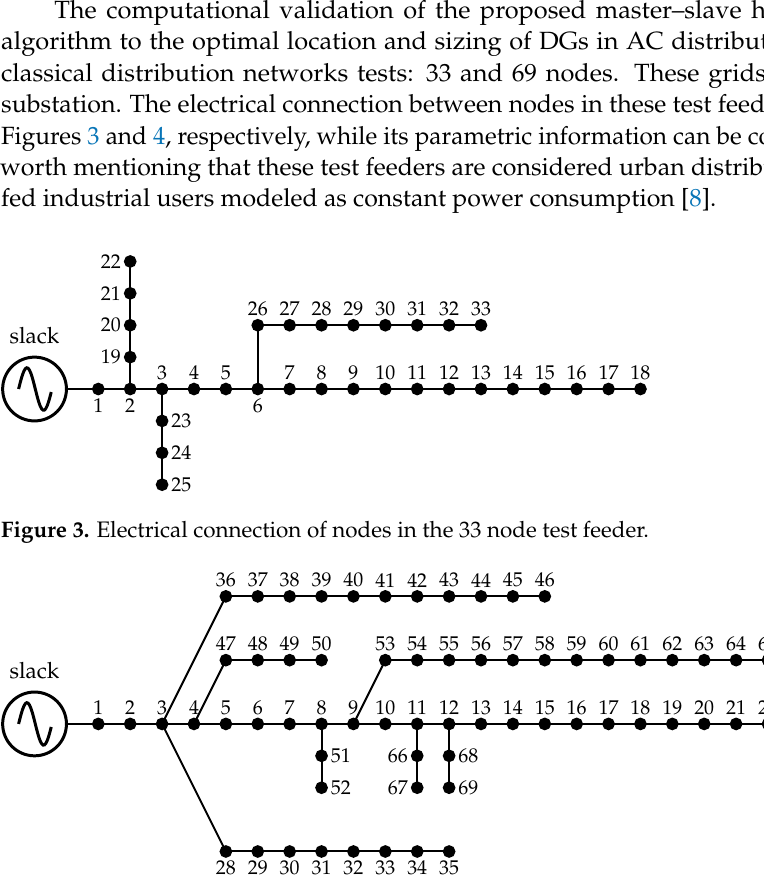
Figure 4. Electrical connection of nodes in the 69 node test